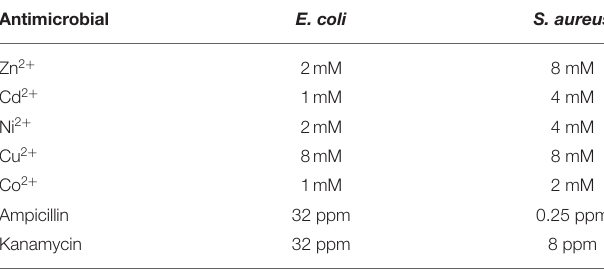
TABLE 1 | Minimum inhibitory concentrations of transition metal ions and antibiotics. Antimicrobial